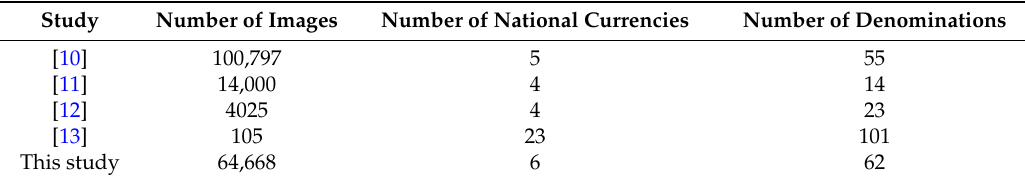
Table 4. Comparison of the numbers of images and classes in the experimental databases used in previous studies and in this study.